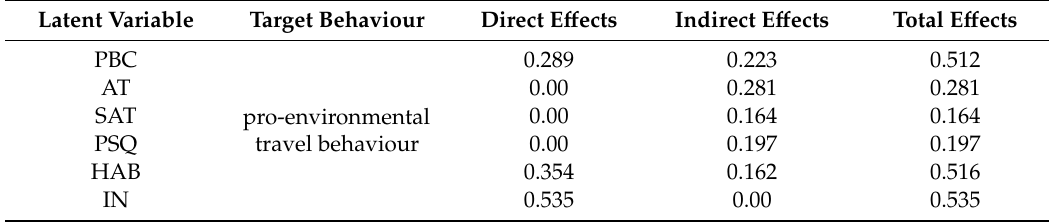
Table 5. Standardised direct, indirect, and total e ff ects of latent variables on target